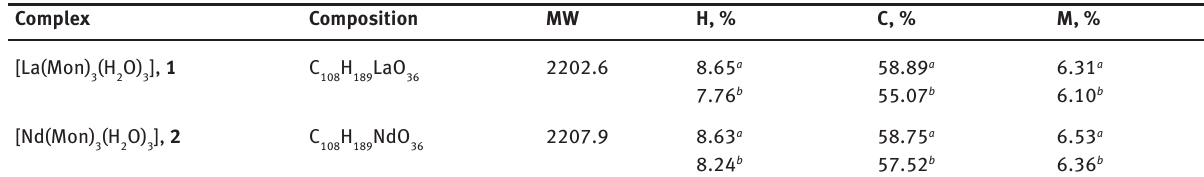
Table 1: Elemental analysis data of lanthanide(III) Monensinates 1 - 2.